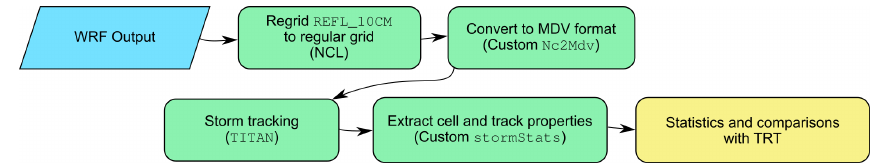
Figure 4. The processing flowchart used in this study for WRF data. Shown are input data (blue) processing steps (green) and analyses (yellow). Nc2Mdv is a modified version of the TITAN tool NcGeneric2Mdv , and stormStats is a modified version of the TITAN tool Storms2Xml2